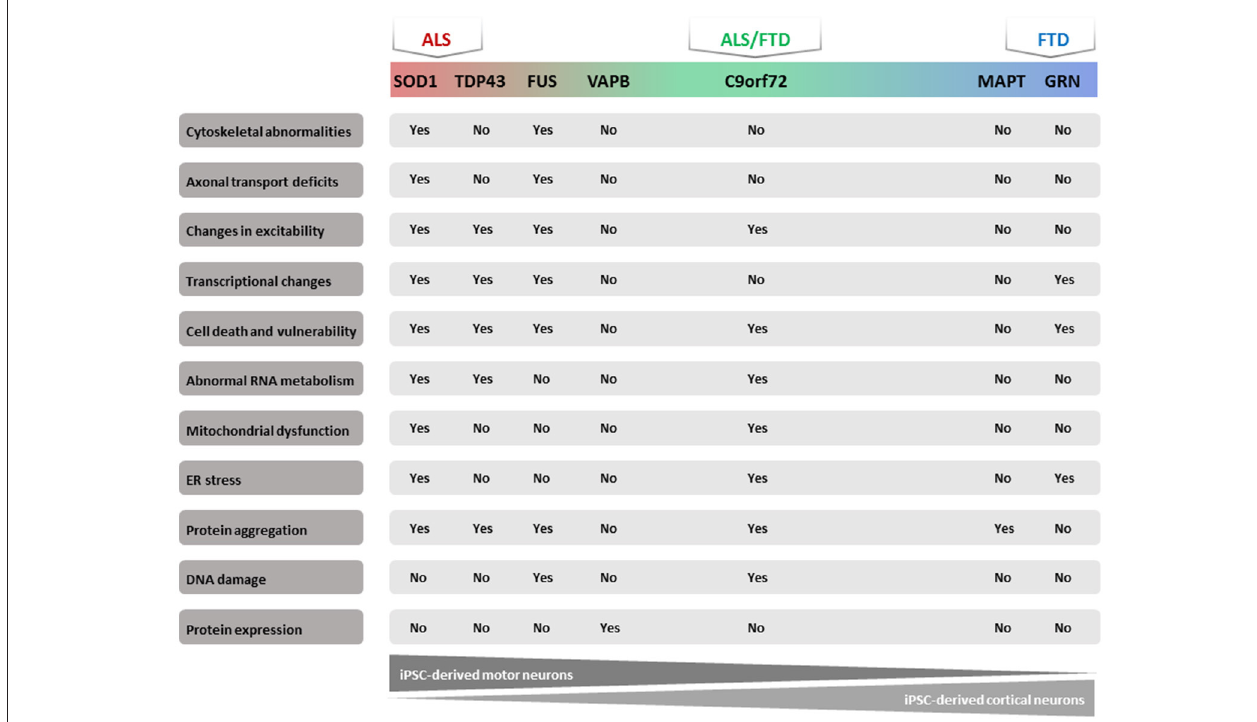
FIGURE 1 | Major phenotypes in ALS/FTD iPSC models. Summary of observed phenotypes from motor neurons or cortical neurons derived from ALS/FTD